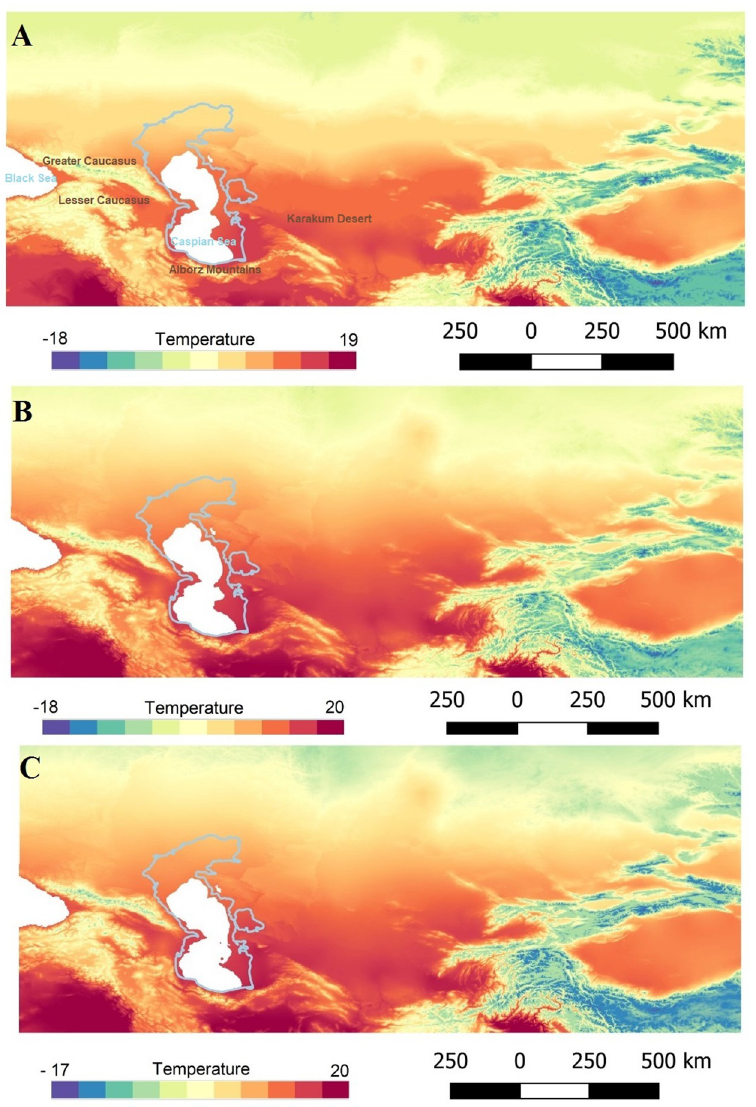
Fig 6. Reconstruction of spatial variations of annual temperature during MIS 4. A: 50 ka, B: 60 ka, C: 70 ka (maps created based on Oscillayers dataset 68 ).